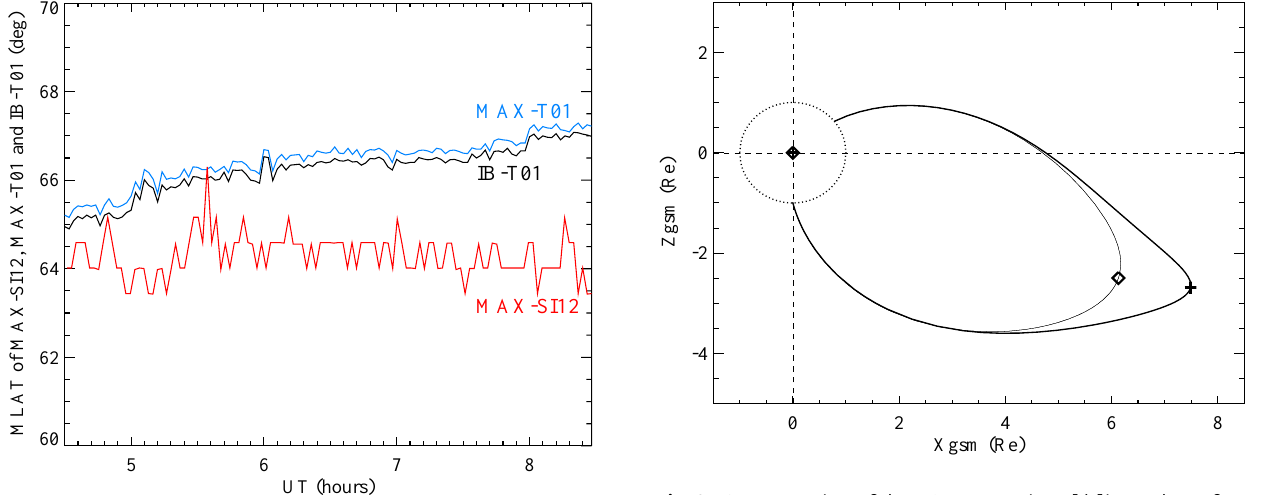
Fig. 2. Configuration of the T01 magnetic field lines whose foot- prints coincide with the latitude of MAX-SI12, for the actual solar wind conditions (thin solid line) and for the adjusted D 0 parame- ter (thick solid line) at 06:30 UT on 5 November 2000. The plus and diamond symbols indicate the apex of the magnetic field lines where R corresponds to 6 and 40.2,